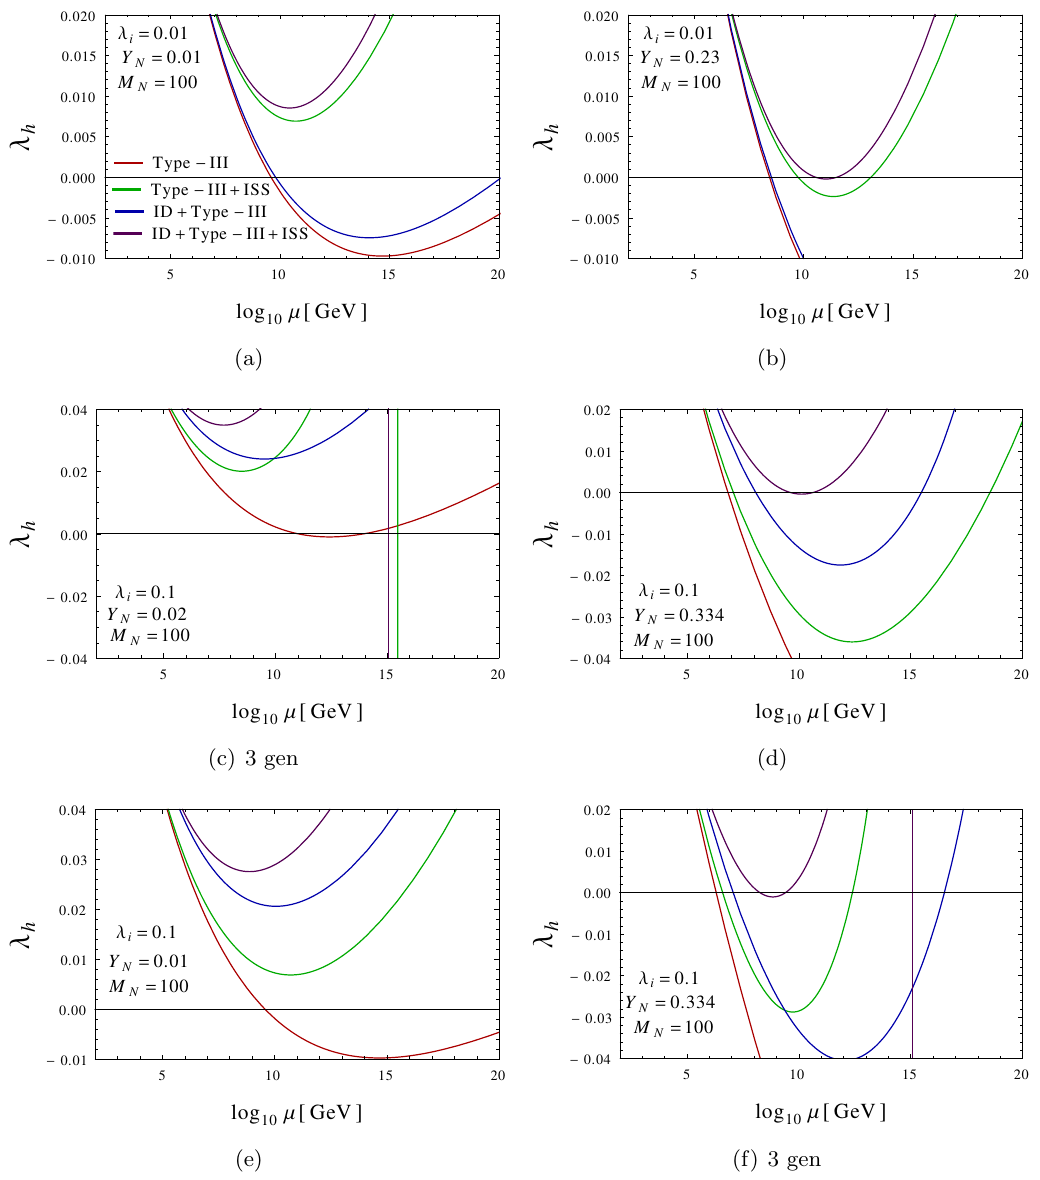
Figure 6 . Two-loop running of the SM-like Higgs quartic coupling (cid:21) h as a function of scale ( (cid:22) ). Here the red, green, blue and the purple curve corresponds to the Type-III, Type-III+ISS, ID+Type-III and ID+Type-III +ISS scenarios respectively for four di(cid:11)erent benchmark values of Y N and Higgs quartic couplings ( (cid:21) 1=2 ; 3 ; 4 ; 5 ) with two generations of fermionic triplet. (c) and (f) are with three-generations of triplet